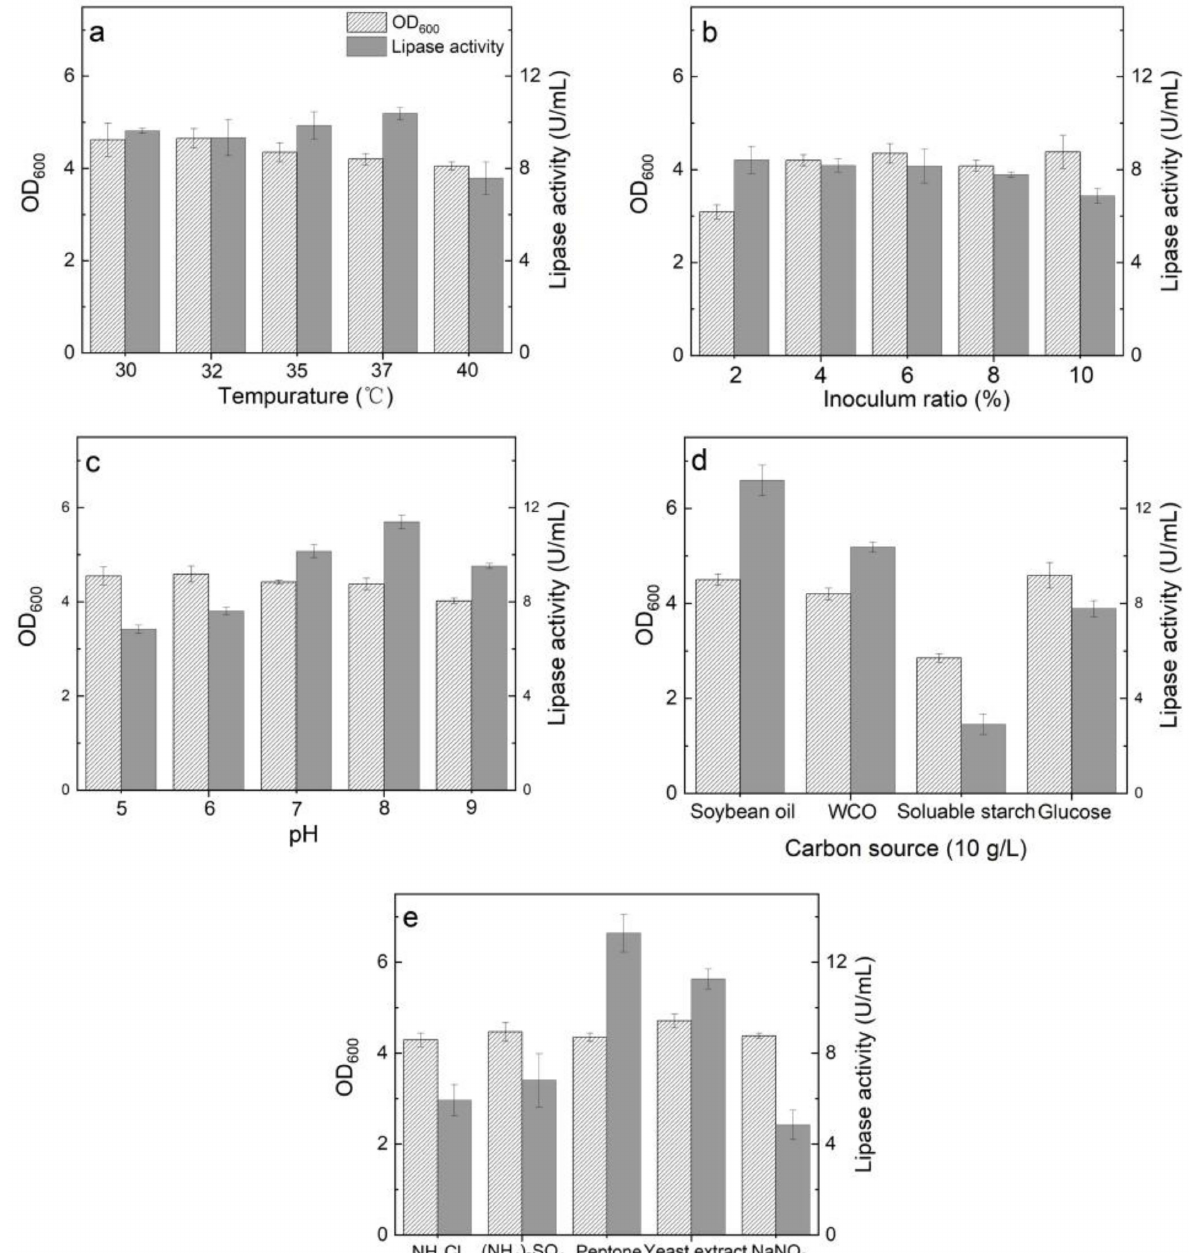
Figure 2. Changes in OD 600 and lipase activity at various ( a ) temperature, ( b ) inoculum ratio, ( c ) pH, ( d ) carbon sources, and ( e ) nitrogen